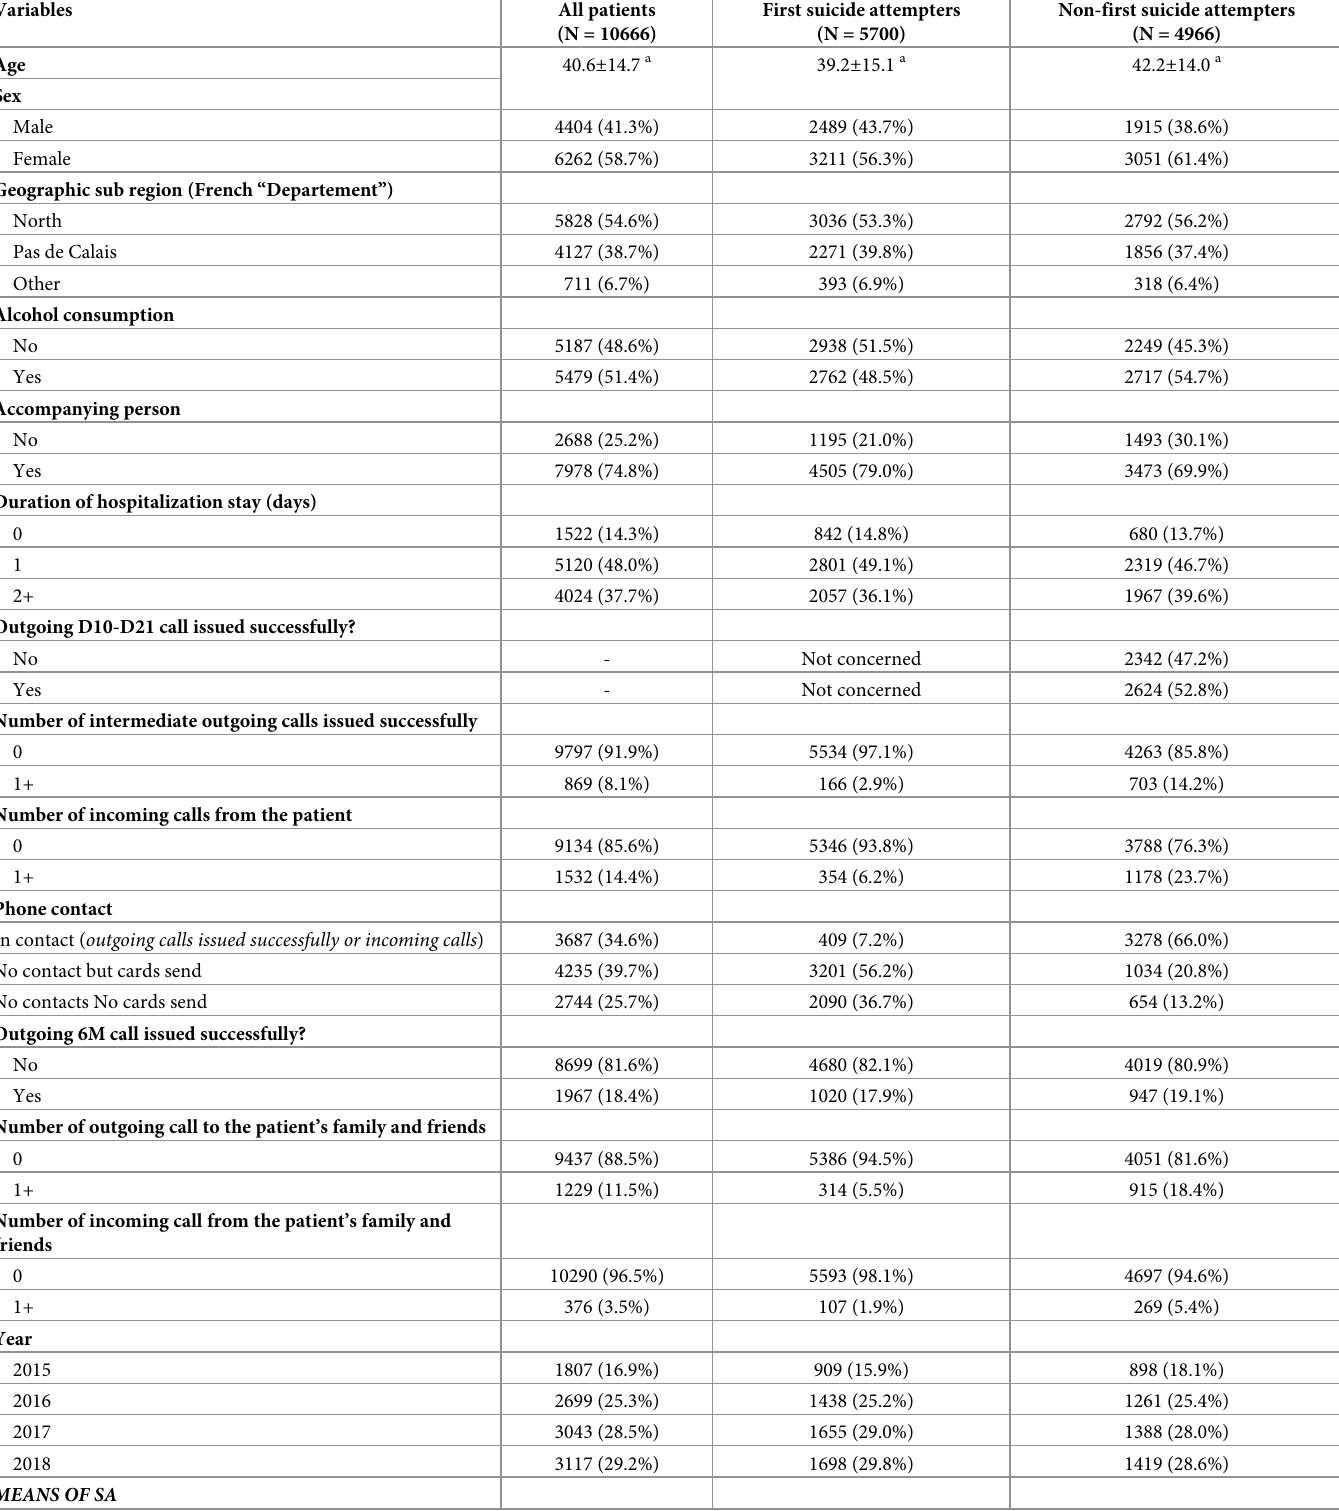
Table 1. Description of patients at first entry into